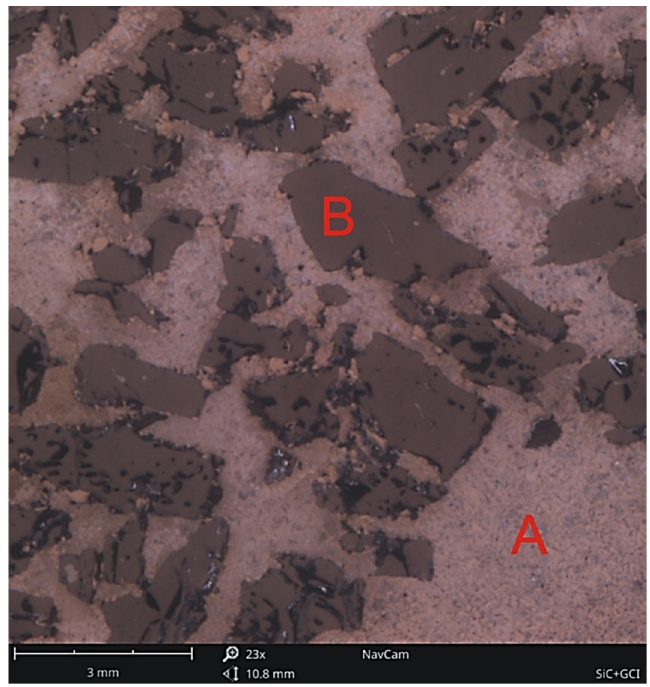
Figure 1. An example of a composite macrostructure of gray cast iron ( A ) and silicon carbide β -SiC ( B ), mag. 23×.